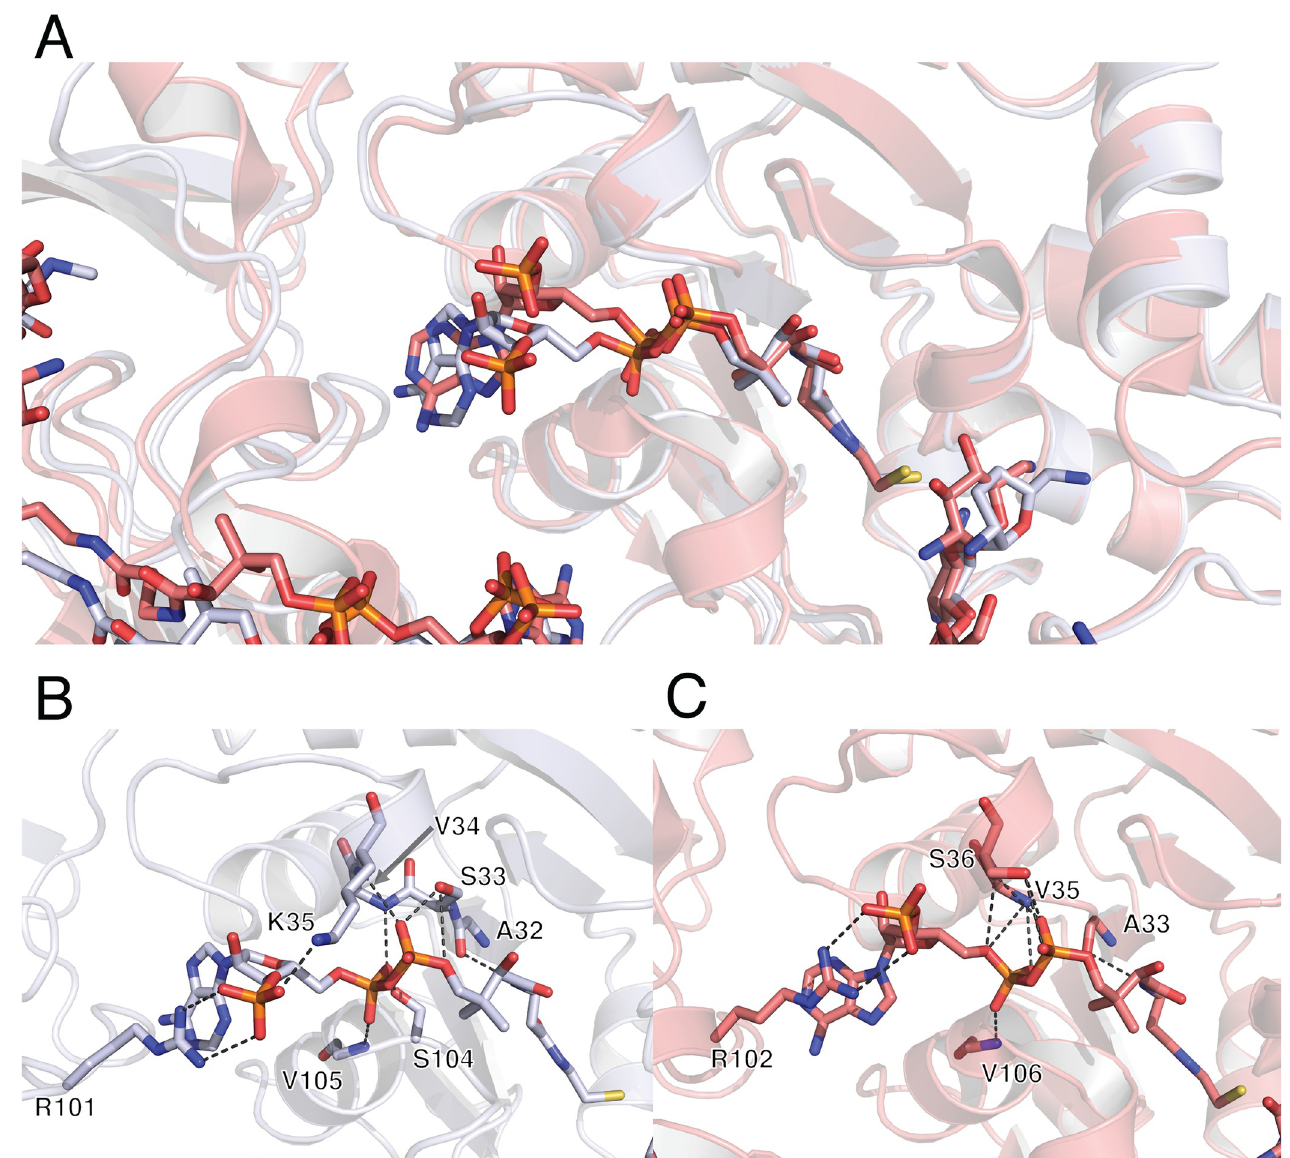
Fig 2. Comparison of CoASH binding to AAC(3)-IIIa and AAC(3)-IIIb. Panel A represent overall superimposition of the two structures. Panel B depicts direct interactions between sisomicin-bound AAC(3)-IIIa and CoASH, whereas panel C depicts direct interactions between neomycin-bound AAC(3)-IIIb and CoASH (PDB ID: